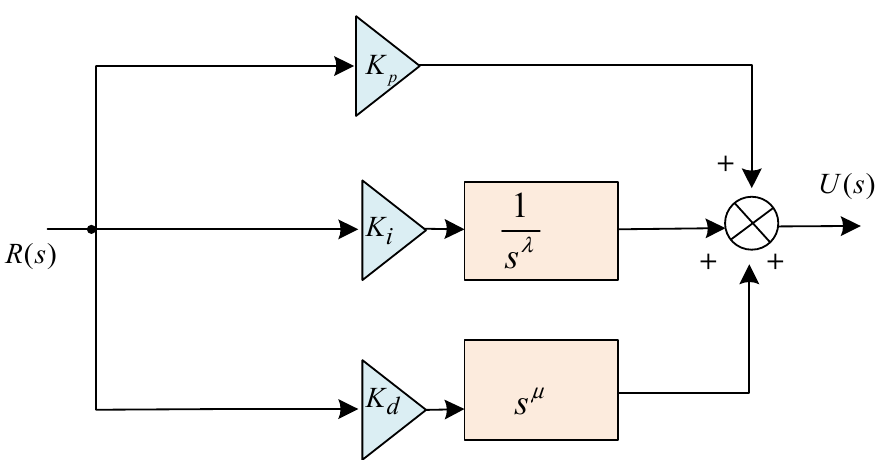
Figure 5. FOPID controller for the LFC analysis of the test system.